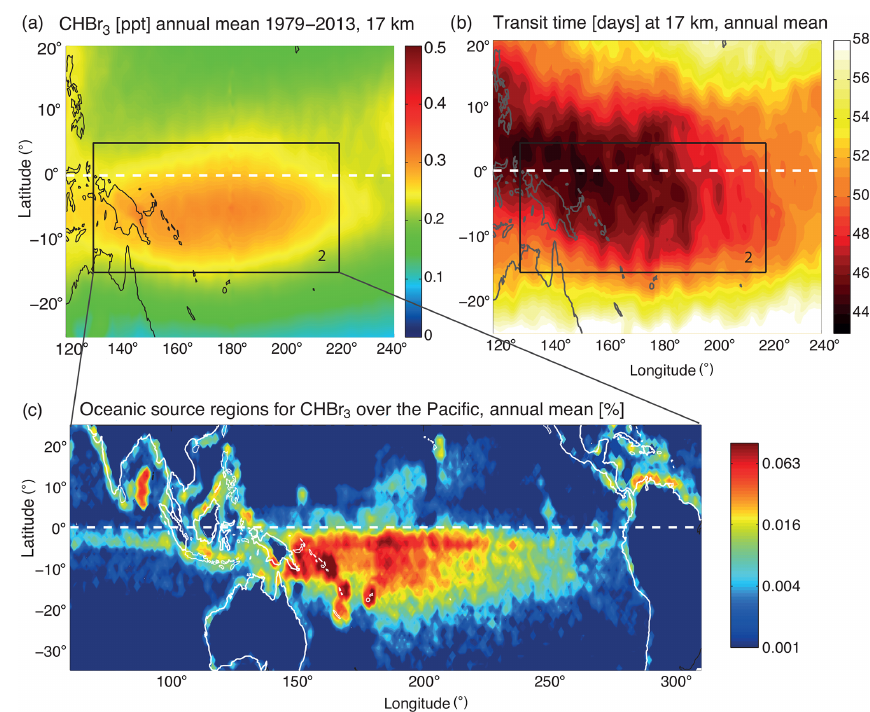
Figure 6. Modelled distribution of CHBr 3 at 17km, annual mean 1979–2013 (a) , transit time of air masses from the ocean surface to the TTL (b) , and oceanic source regions for CHBr 3 at 17km (c) . Oceanic source regions are colour coded according to their contribution (% per 1 ◦ × 1 ◦ grid box) to the amount of CHBr 3 at 17km in the black box over the west Pacific (highlighted in a and b